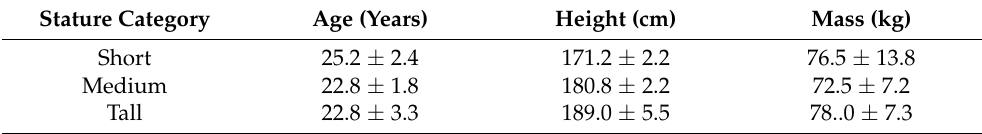
Table 2. Participant height, mass and age, n = 5 per stature category (mean ± standard